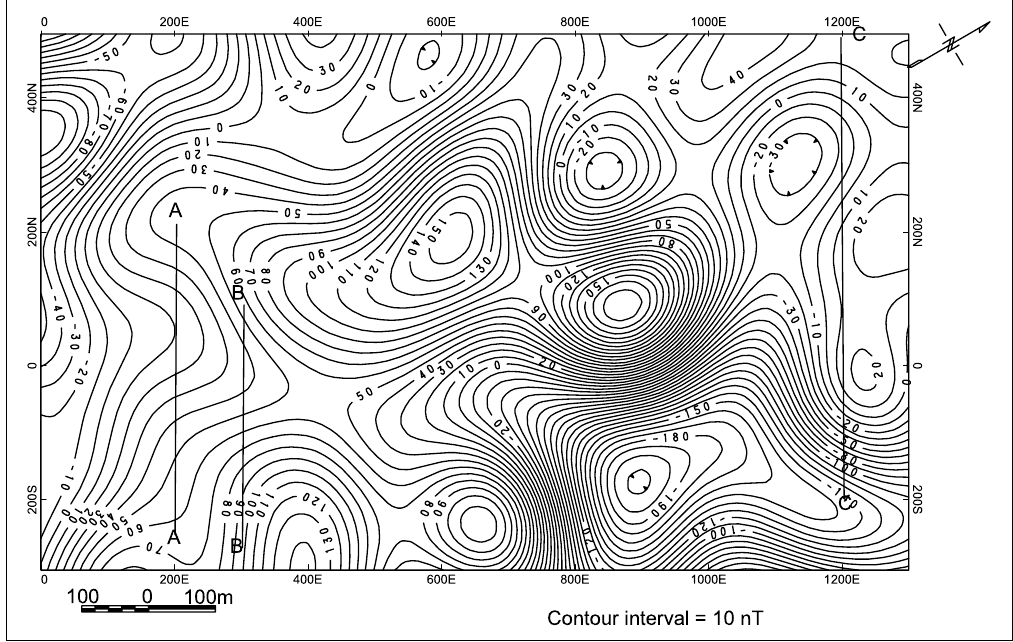
Fig. 7. Low-pass filtered (frequency = 6-65 cycles/km) magnetic map of the Abu-Shihat radioactive prospect area, North Eastern Desert,